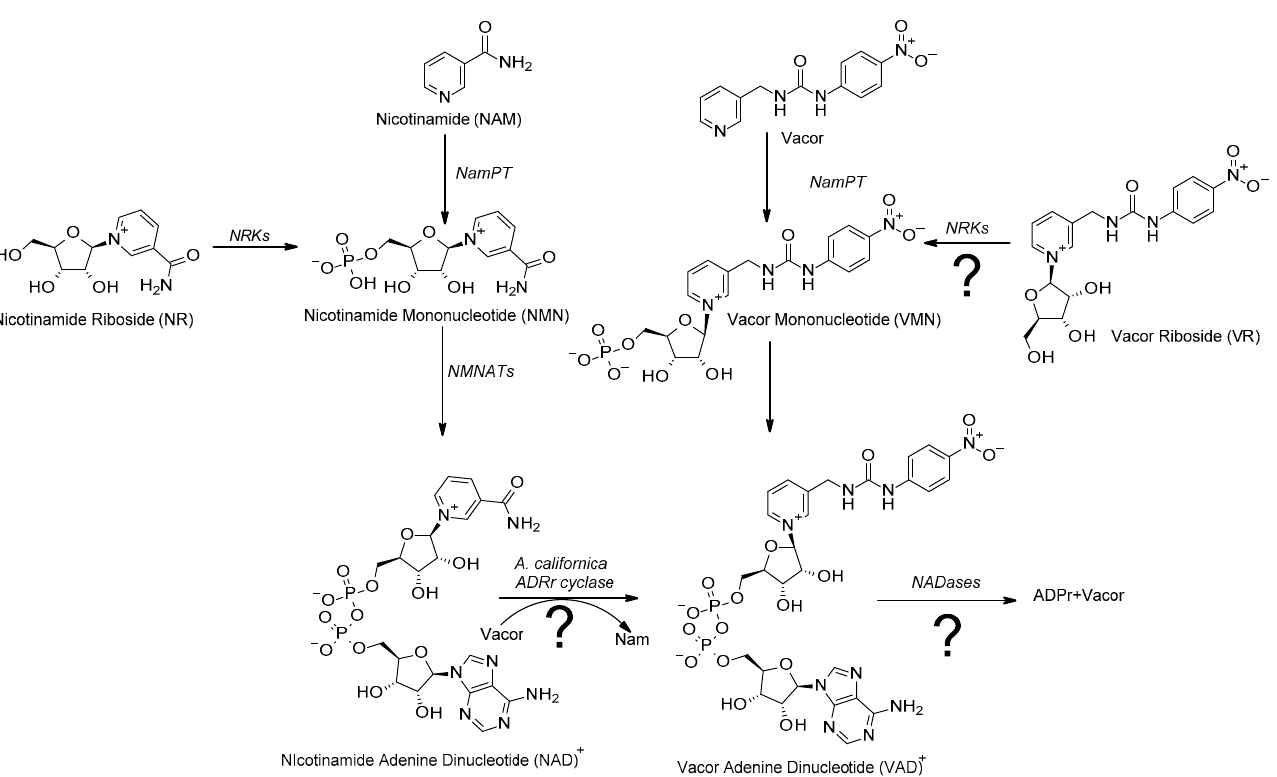
Figure 1. Vacor acts as an analogue to nicotinamide: Overview of the salvage pathway of NAD biosynthesis (left). Nicotinamide is converted to nicotinamide mononucleotide (NMN) in a rate-limiting reaction catalyzed by nicotinamide phosphoribosyl transferase (NamPT). NMN is then converted to NAD in a reaction catalyzed by nicotinamide mononucleotide adenylyl transferases (NMNATs). The alternative NAD precursor nicotinamide riboside (NR) enters the pathway by conversion to NMN catalyzed by nicotinamide riboside kinases (NRKs). Vacor is converted to an NAD analogue through the same pathway, being converted to vacor mononucleotide (VMN) by NamPT and then further converted to vacor adenine dinucleotide (VAD) by NMNAT2. Possible alternative pathways for generating or consuming VAD that are addressed in the present study are indicated with question marks.